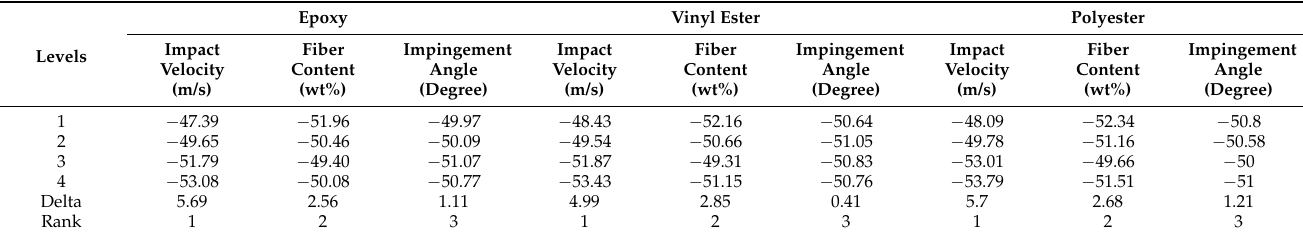
Figure 6. Mean of S/N ratio for epoxy (ep), vinyl ester (ve) and polyester (pe) based composites. Table 7. Response table for